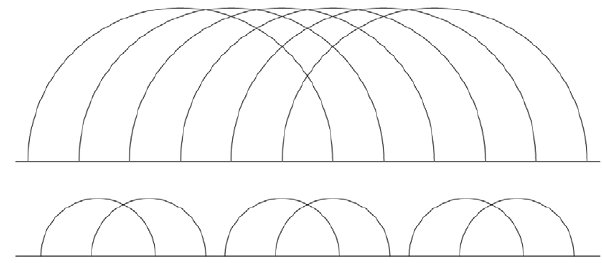
Figure 1. Two sample RNA secondary structures both having genus values =3. Both structures have their own genus equal to 3, but the lower one is a concatenation of three H-pseudoknots of genus equal to 1. The genus of the whole structure is the sum of the genera of its primitive components.